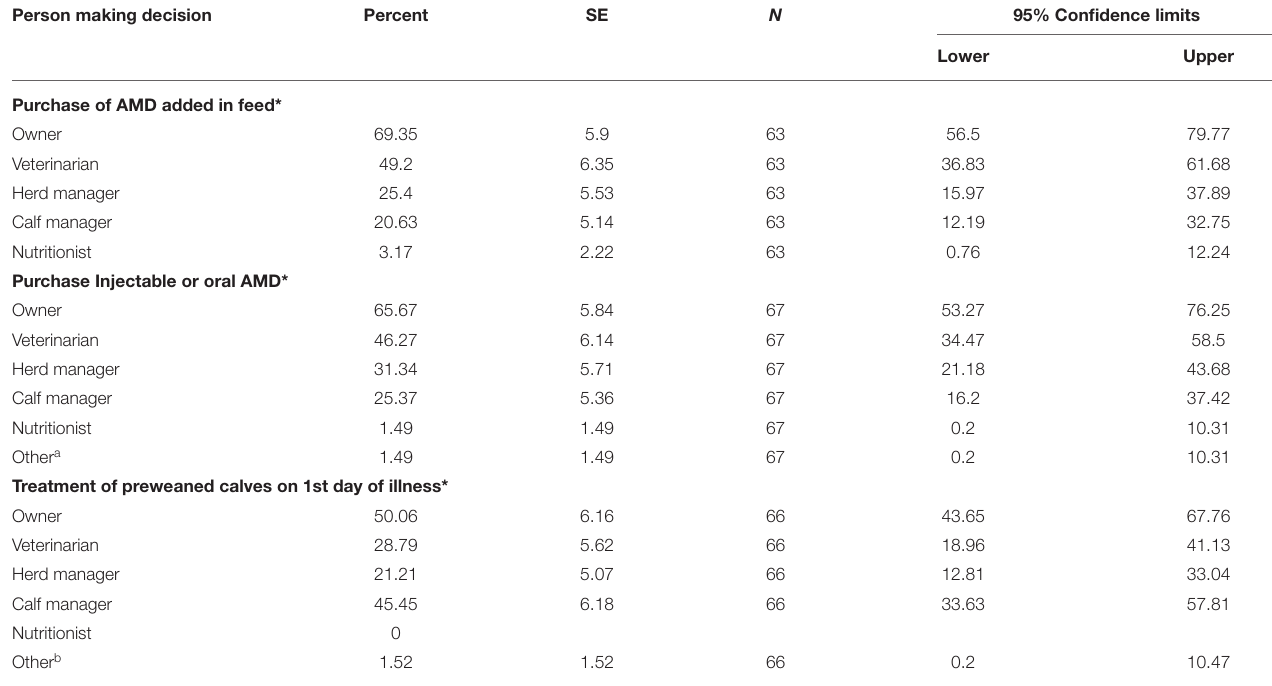
TABLE 8 | Decision making on antimicrobial drugs (AMD) purchased and used to treat sick calves on California dairies. Person making